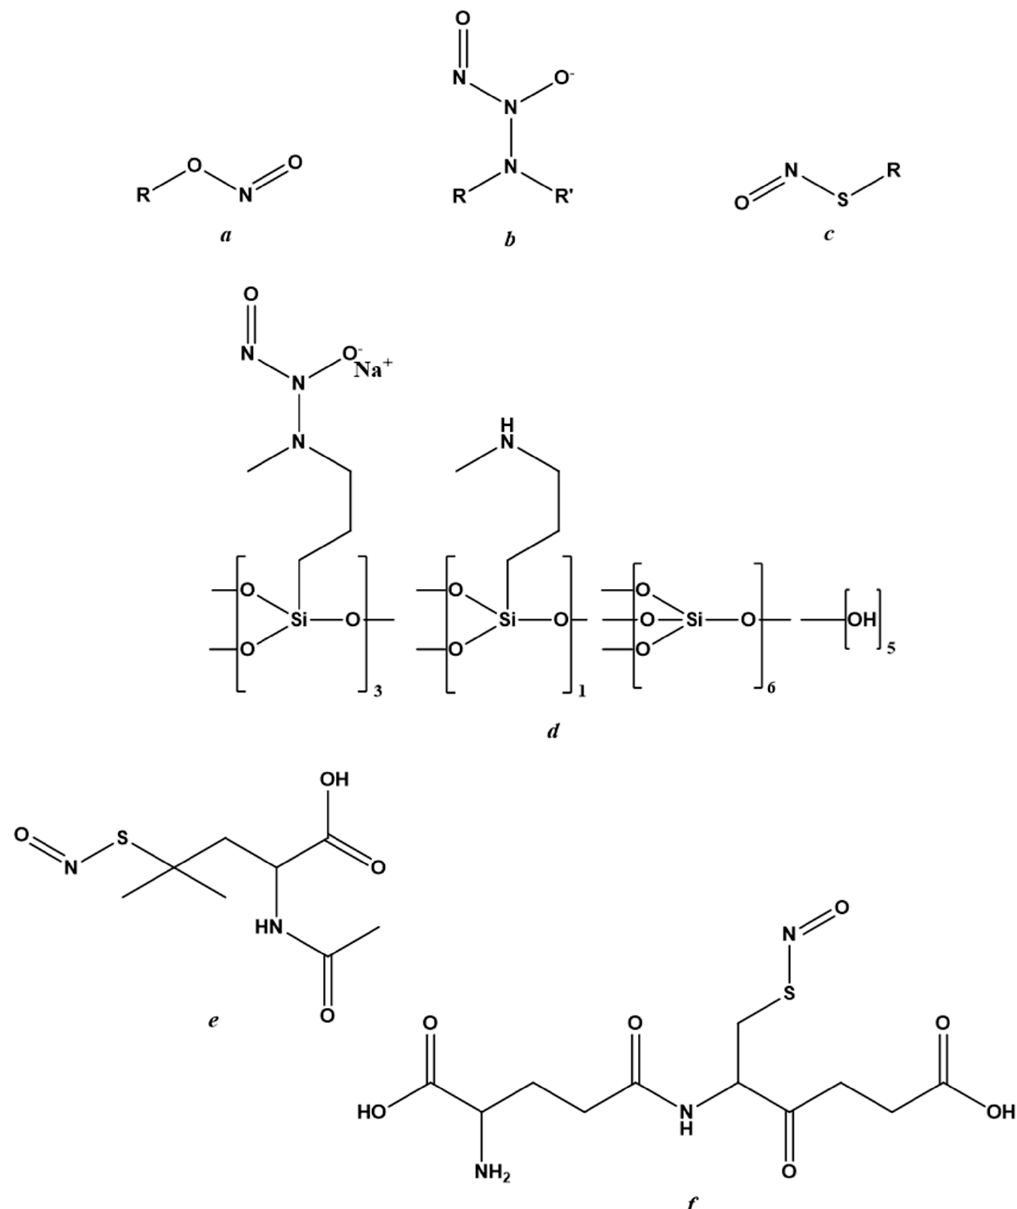
Figure 2. Chemical structure of NO-donors. ( a ) nitrites; ( b ) N -diazeniumdiolates; ( c ) S-nitrosothiols; ( d ) berdazimer sodium; ( e ) S-nitroso- N -acetylpenicillamine; ( f ) S-nitrosoglutathione.